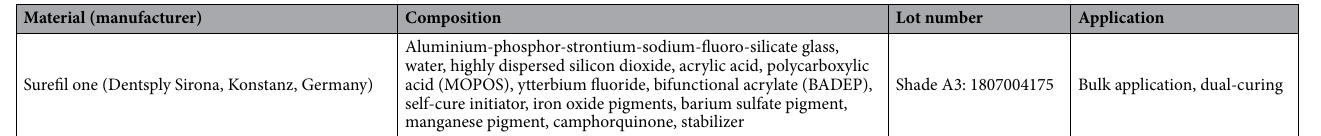
Material (manufacturer) Composition Lot